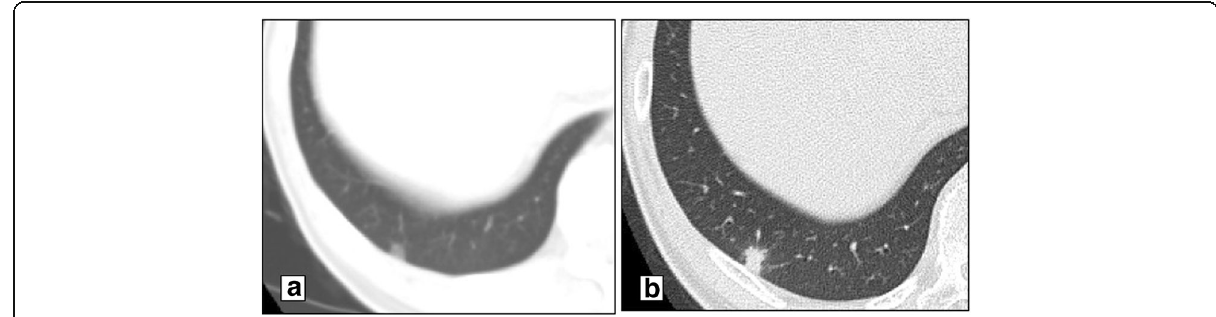
Fig. 2 Imaging studies of the second pulmonary metastasis. Chest CT (at the same time when another nodule was found in the lower lobe of the left lung) shows a tiny nodule in the lower lobe of the right lung. It is difficult to determine whether this nodule is a metastatic tumor or an inflammatory nodule. a Follow-up chest CT (94 months after curative resection of the primary pancreatic tumor) shows that this nodule has increased gradually. b